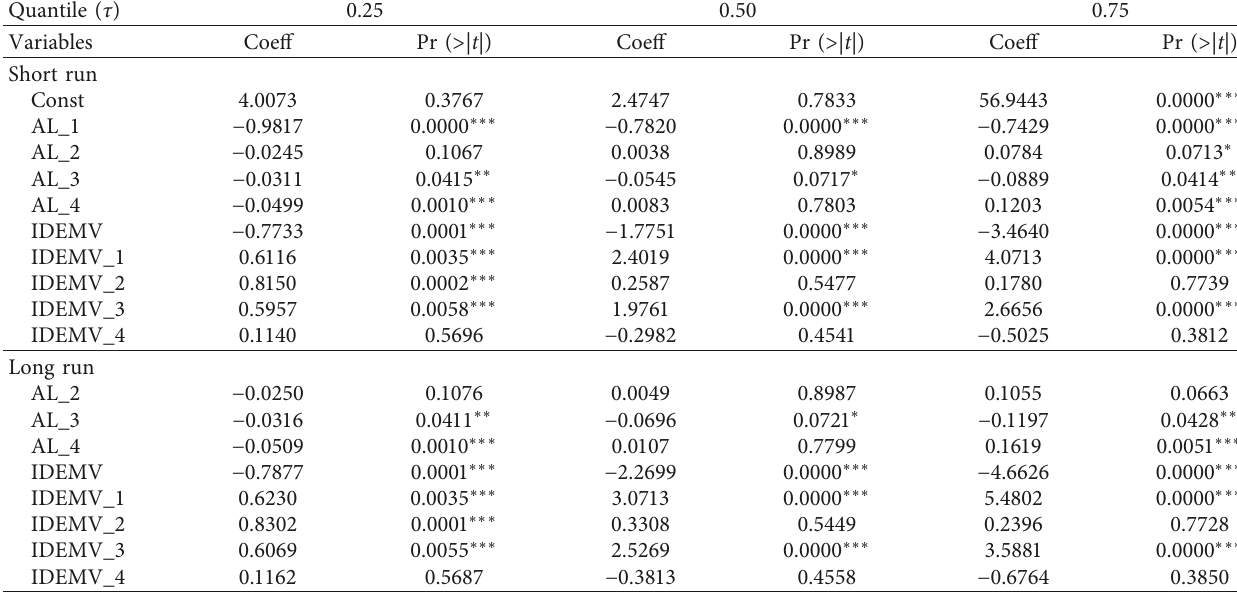
Table 11: QARDL estimation results: pandemic period (independent variable: